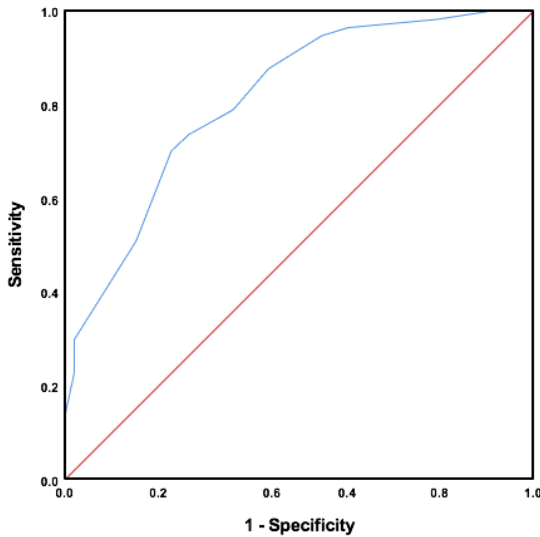
Figure 1. Receiver operating characteristic curve for the Arabic FRQ.